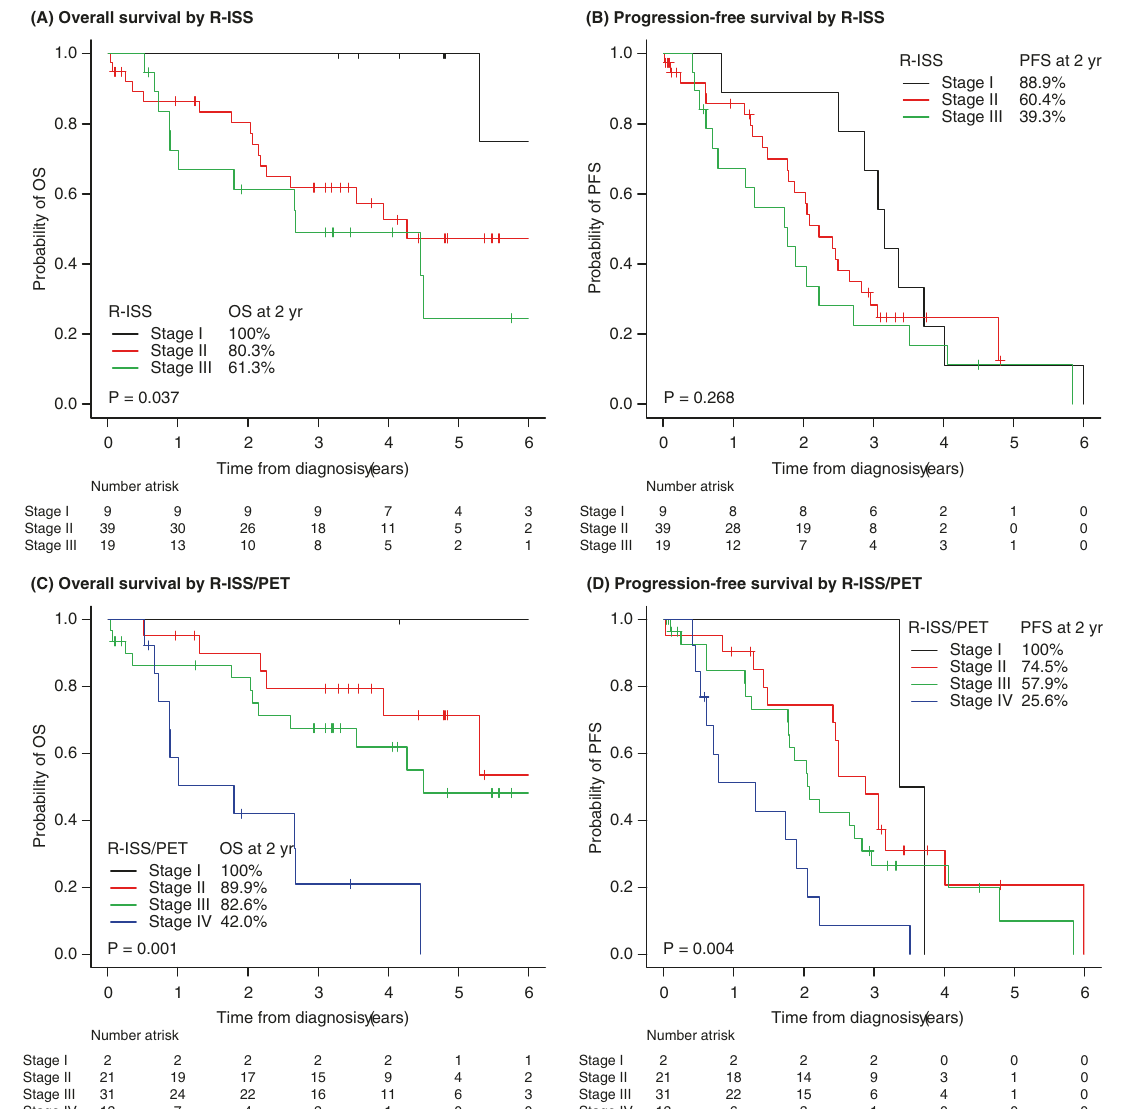
Fig. 4 Comparison of the R-ISS and the R-ISS/PET survival curves in the external validation cohort. A , B Overall survival (OS) rates and progression-free survival (PFS) rates by the R-ISS. C , D OS and PFS rates by the R-ISS/PET in the external validation cohort. Abbreviation: R-ISS Revised International Staging System, R-ISS/PET Revised International Staging System/positron emission